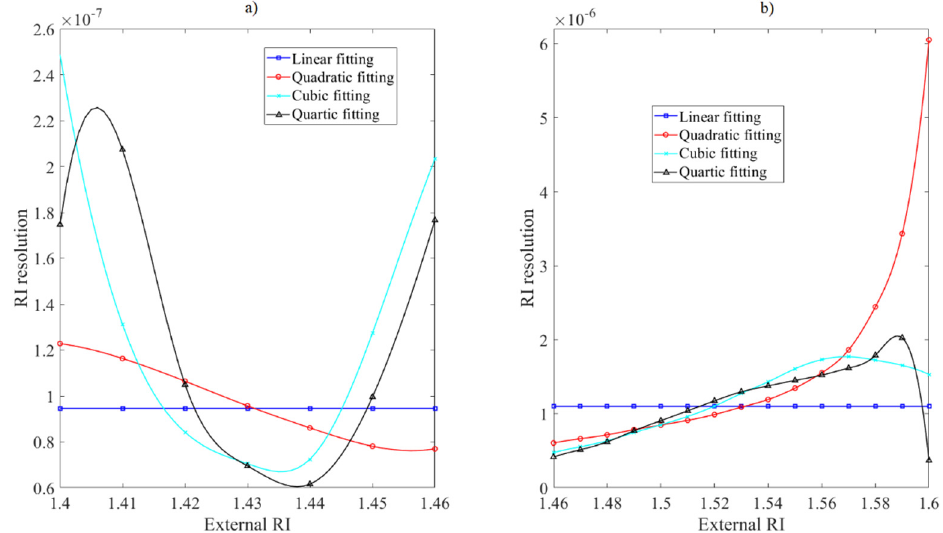
Figure 13. Resolution trends, in RI ranges ( a ) 1.40–1.46 and ( b ) 1.46–1.60, for different fitting functions with α = 2.